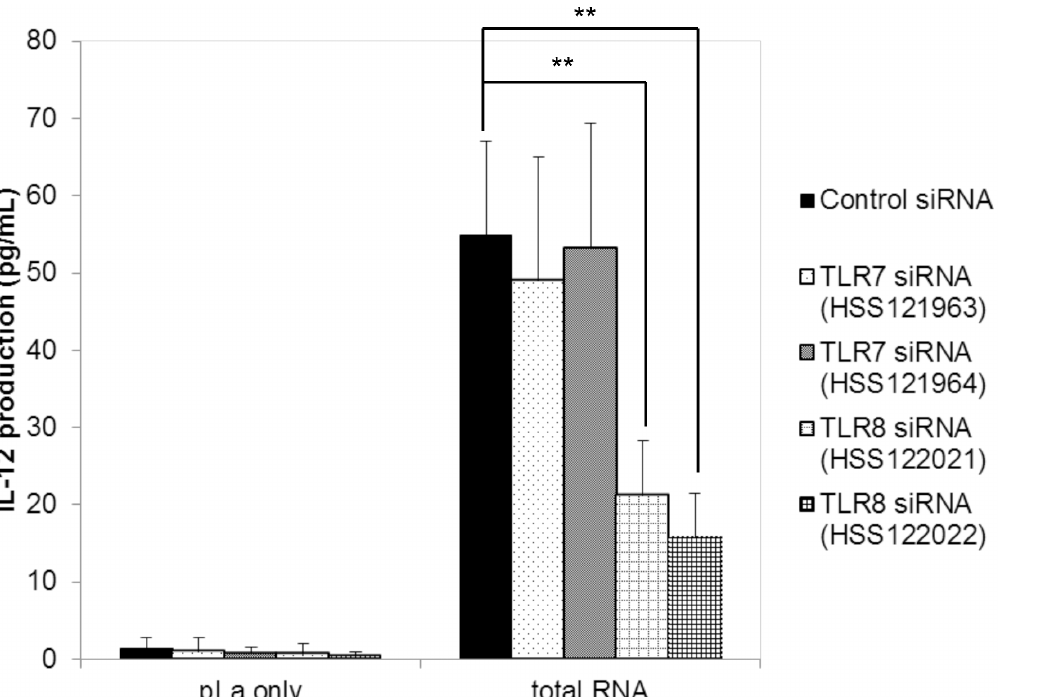
Fig 3. Effect of siRNA treatment on IL-12 production against total RNA of E . faecalis EC-12. siRNA treatment was performed as described in Material and Methods. Fragmented total RNA (7 μ g/mL) from E . faecalis EC-12 was transfected using pLa to PMA-differentiated THP-1 cells after siRNA treatment. After 24 h of incubation, the concentration of IL-12 protein in the culture supernatant was measured using enzyme-linked immunosorbent assay. ** : P < 0.01, mean ± SD, n = 6.